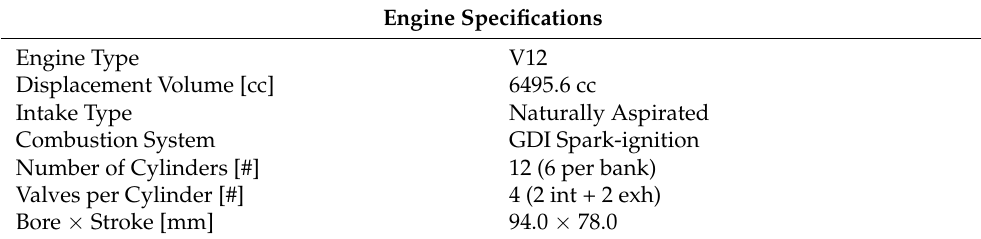
Table 1. Engine Specifications.